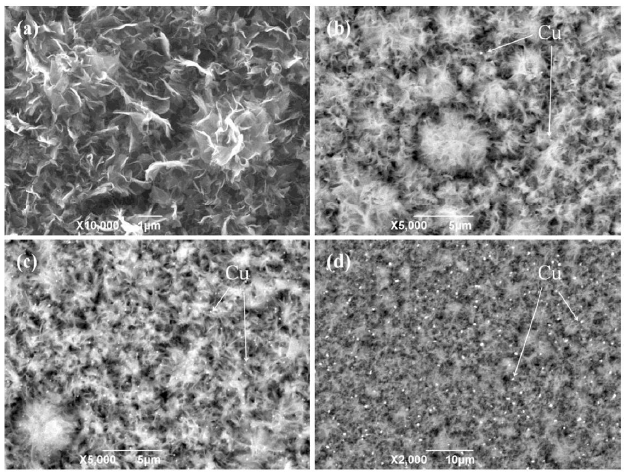
Figure 6. SEM picture of pure TiO 2 film ( a ) and Back Scattered Electrons images of TiO 2 NFFs containing increasing amounts of Cu from ( b – d ). Reprinted from Mater. Res. Bull. , 68, Liu, E.; Qi, L.; Bian, J.; Chen, Y.; Hu, X.; Fan, J.; Liu, H.; Zhu, C.; Wang, Q., A Facile Strategy to Fabricate